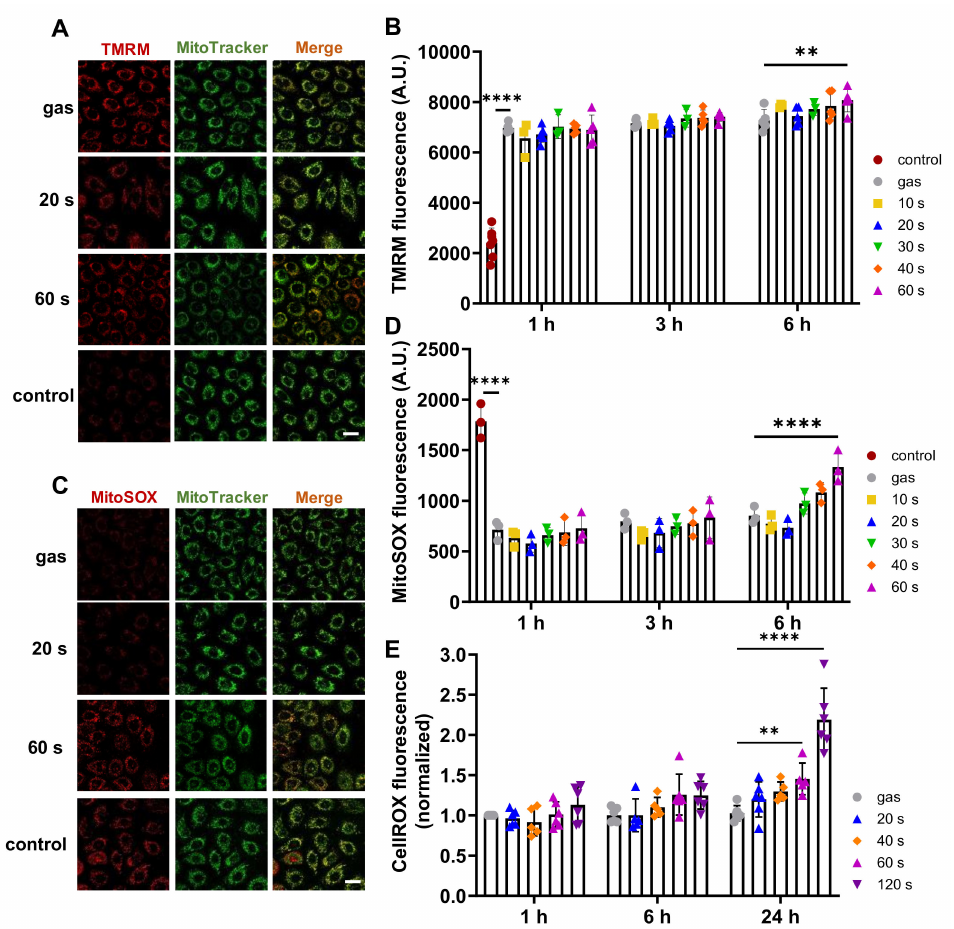
Figure 2. CAP treatment of less than 60 s did not affect N/TERT 1 mitochondria and intracellular ROS. N/TERT-1 cells were exposed to CAP for 10–60 s. Putative changes in mitochondrial membrane potential were determined by TMRM fluorescence assay 1 h, 3 h and 6 h post-treatment. Represen- tative confocal microscopy images are shown ( A ) and fluorescence intensities were quantified by flow cytometry ( B ). We used 2 µ M CCCP as positive control for membrane depolarization. n = 3. Mitochondrial dysfunctions were detected using the MitoSOX Red fluorescence assay. Representative confocal microscopy images are shown ( C ) and fluorescence intensities were quantified by flow cytometry ( D ). Two µ M antimycin was used as positive control for mitochondrial anion superoxide production. n = 3. Changes in intracellular ROS levels were detected using green CellROX reagent by flow cytometry ( E ). Scale bars correspond to 20 µ m. Error bars represent S.D.; **, p < 0.005; ****, p < 0.0001; ns: not